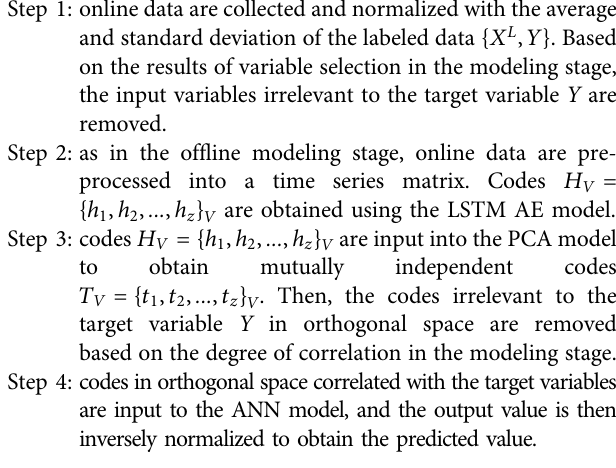
Frontiers in Chemical Engineering |